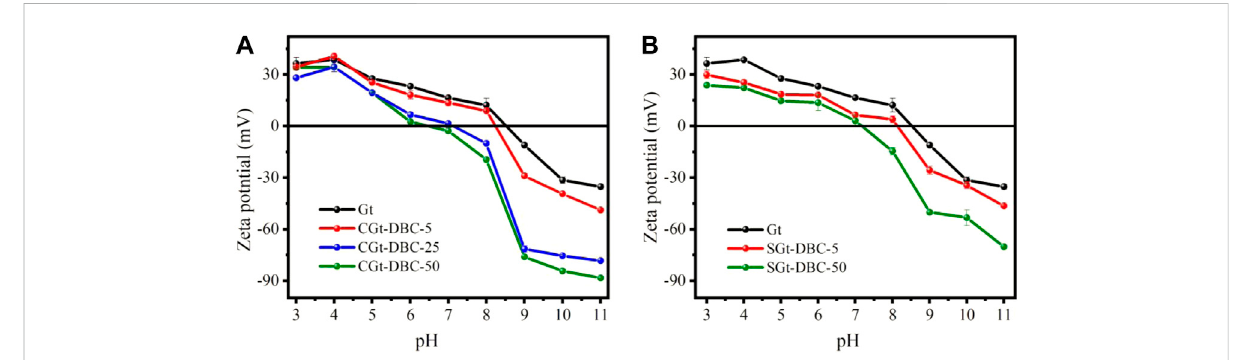
FIGURE 6 Zeta potential of Gt and Gt-DBC samples under different pH conditions (CGt-DBC, the coprecipitated Gt-DBC complexes; SGt-DBC, the adsorbed Gt-DBC complexes; Numbers indicate the additive concentration of DBC in the preparation of Gt-DBC samples).